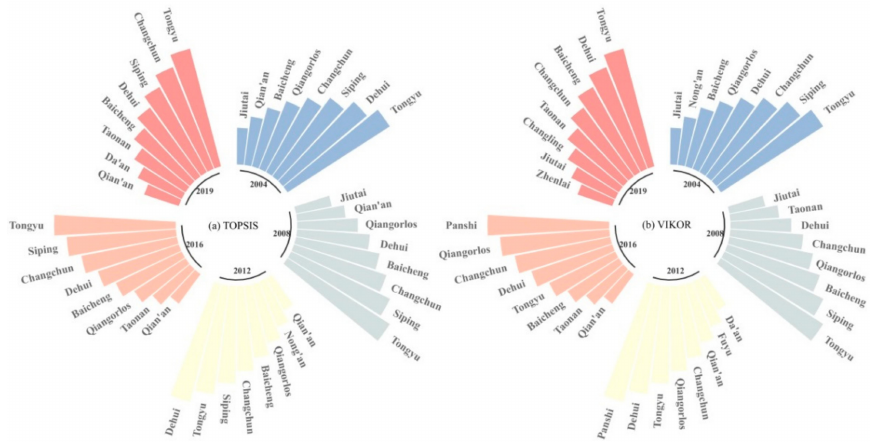
Figure 9. Ranking of drought risk index based on TOPSIS and VIKOR